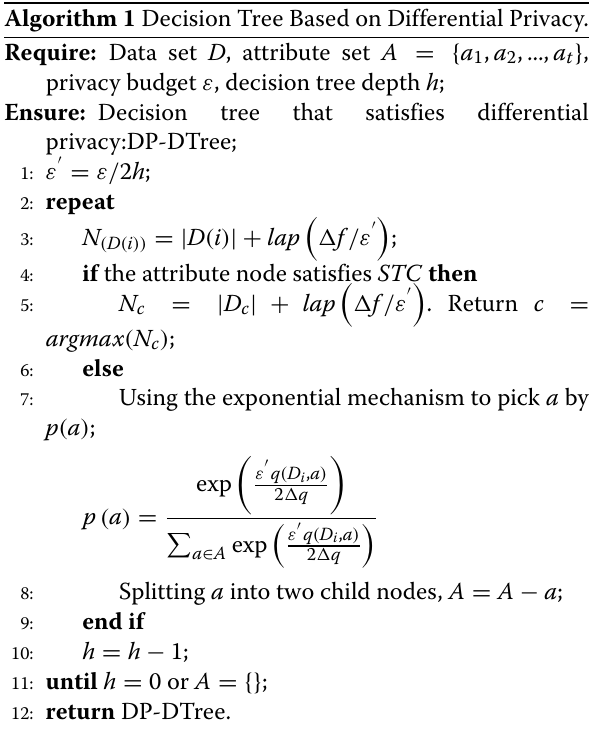
Algorithm 1 offers the pseudo-code of the decision tree algorithm based on differential privacy. D ( i ) and D c represent samples at non-leaf nodes and leaf nodes, follows: